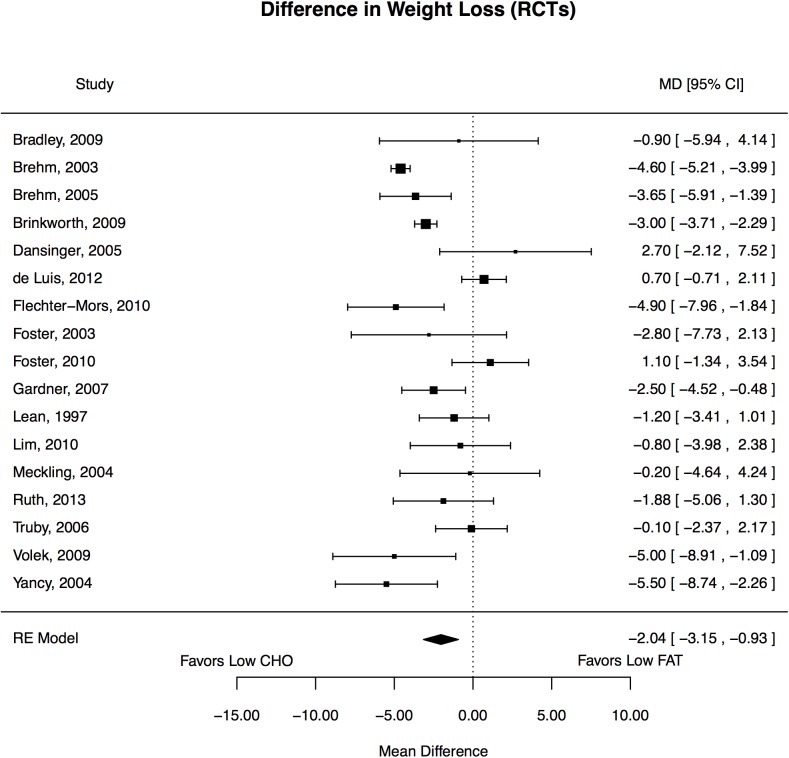
Forest plot of effects of diet on weight in the overweight and obese.